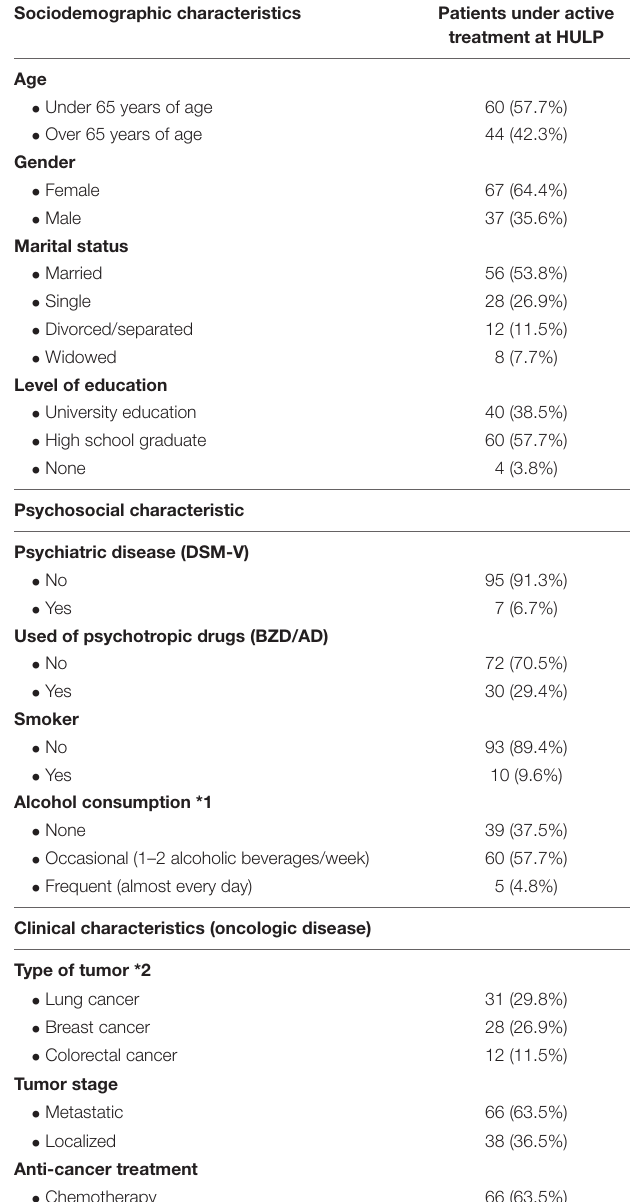
TABLE 1 | Baseline characteristics of the surveyed population ( n =